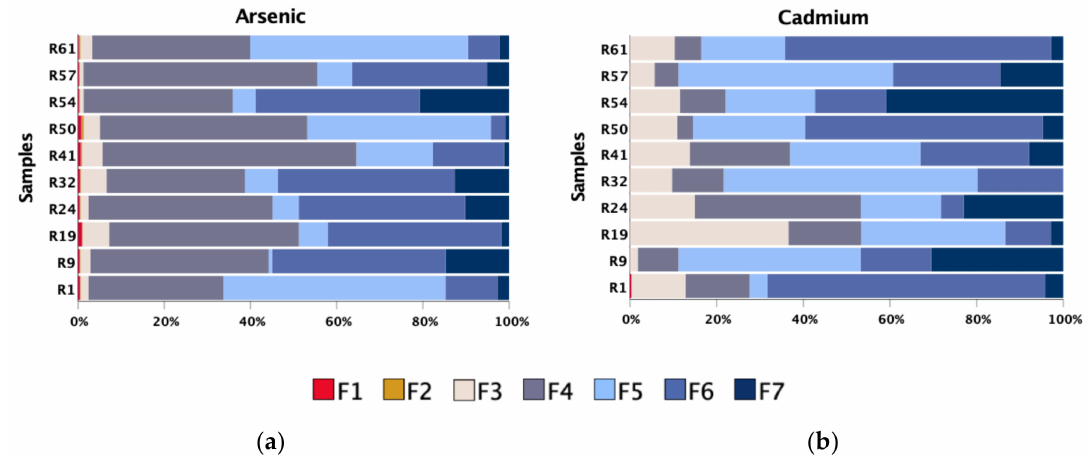
Figure 7. Extraction percentage of ( a ) As and ( b ) Cd obtained by sequential selective chemical extraction (SSCE) in selected soil samples: (F1) exchangeable ions (bioavailable fraction), (F2) acid-soluble forms, (F3) Mn-oxides, (F4) amorphous Fe-oxyhydroxides, (F5) organic matter and sulphides (partially), (F6) crystalline Fe-oxides and (F7) resistant minerals (such as silicates and some oxides and